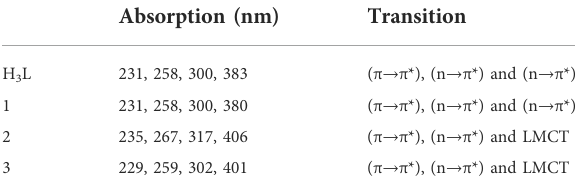
TABLE 2 Electronic spectra ofthe ligand and the corresponding Zn(II), Cu(II) and Ni(II)